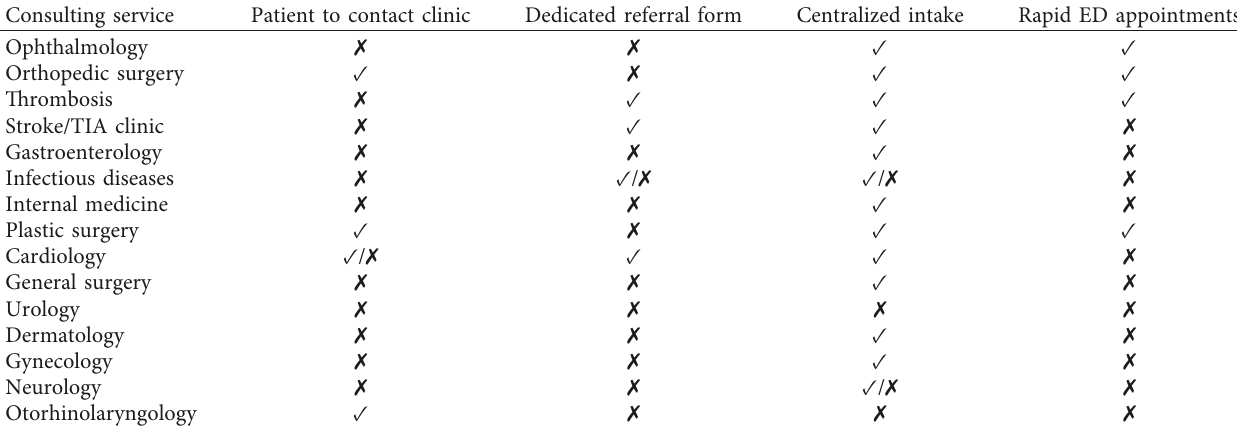
Table 2: Qualitative analysis of outpatient referral processes from the emergency department. Consulting